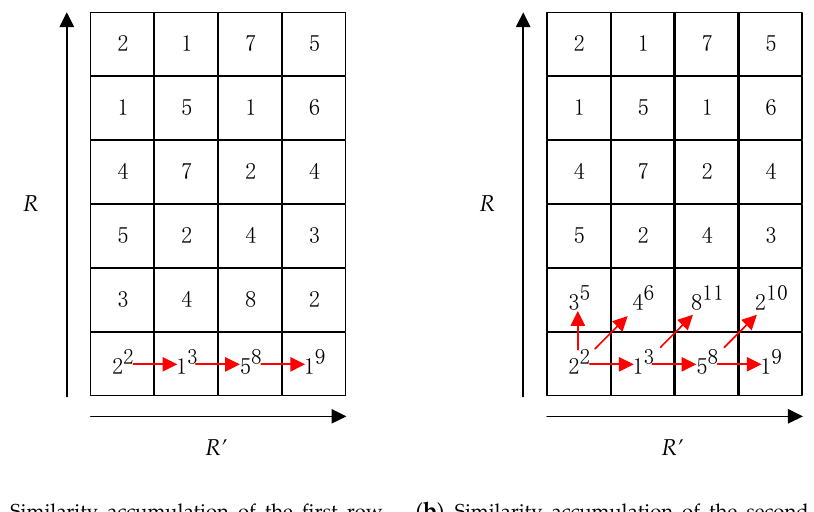
Figure 6. Similarity accumulation.